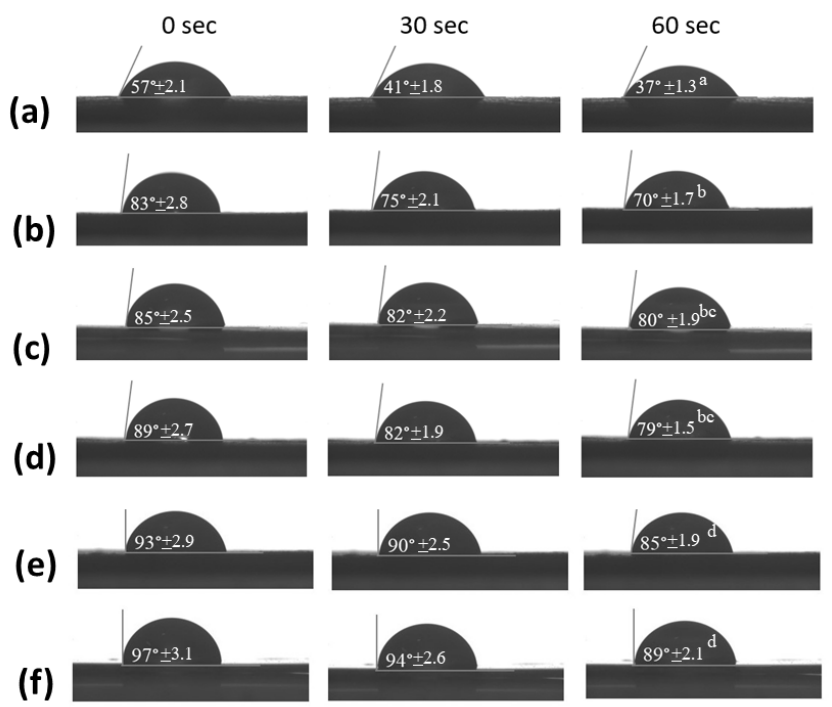
Figure 4. Water contact angles ( n = 5) of ( a ) CS/HPMC/Beeswax3, ( b ) CS/CMC/Paraffin3, ( c ) CS/CMC/Paraffin0.5, ( d ) CS/CMC/Beeswax0.5, ( e ) CS/HPMC/Paraffin0.5, and ( f ) CS/CMC/Paraffin(L)0.5. Means with different lowercase superscript letters were significantly different ( p < 0.05).